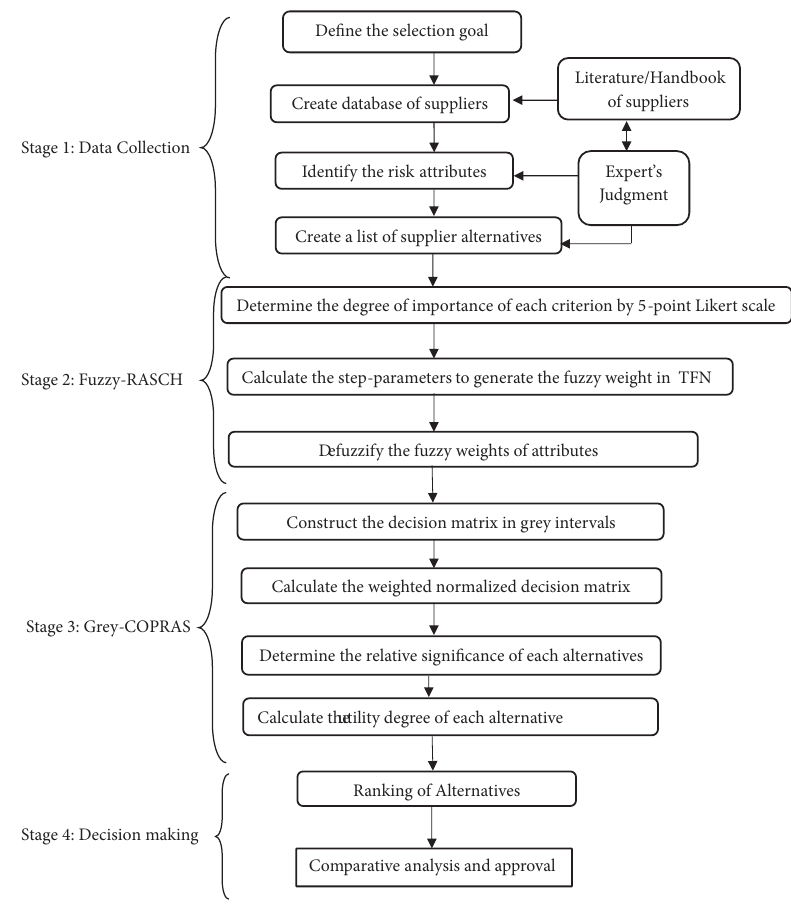
Figure 4. Flowchart of the proposed hybrid fuzzy-Rasch based CORPAS-G